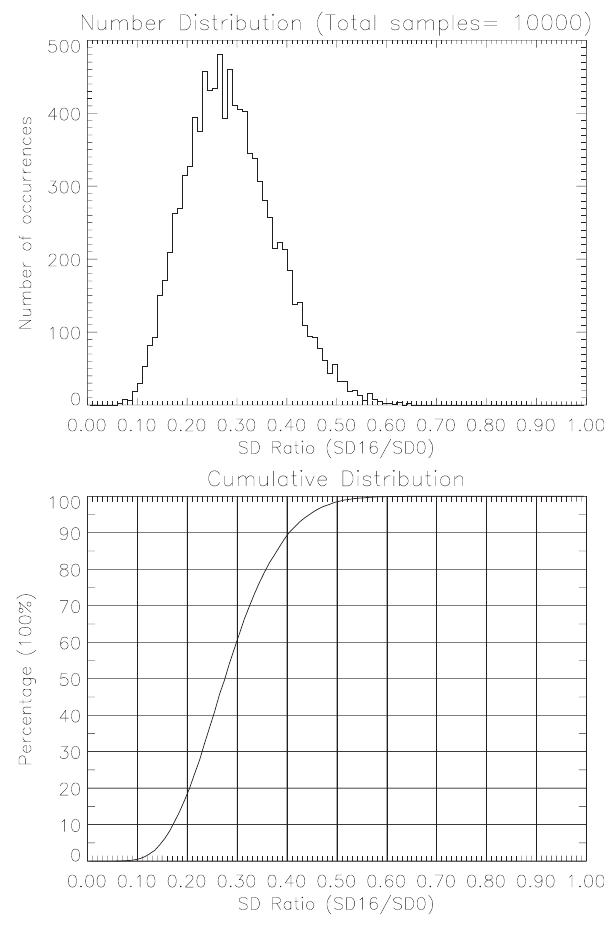
Fig. 3. The histogram is an occurrence (number) distribution of ra- tios of standard deviations of the output (SD16) and input signals (SD0) for a band-pass filter. The inputs are Gaussian random se- quences with red noise characteristics, and the outputs are the “16- day wave” series. The smooth curve is the cumulative distribution of the histogram. In terms of statistics the cumulative distribution actually offers the significance level 1 − P % (percentage of chance) of a ratio being larger than a certain value